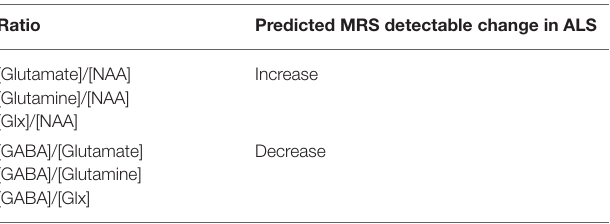
TABLE 1 | Summary of predicted MRS detectable changes in the pathogenesis of ALS.